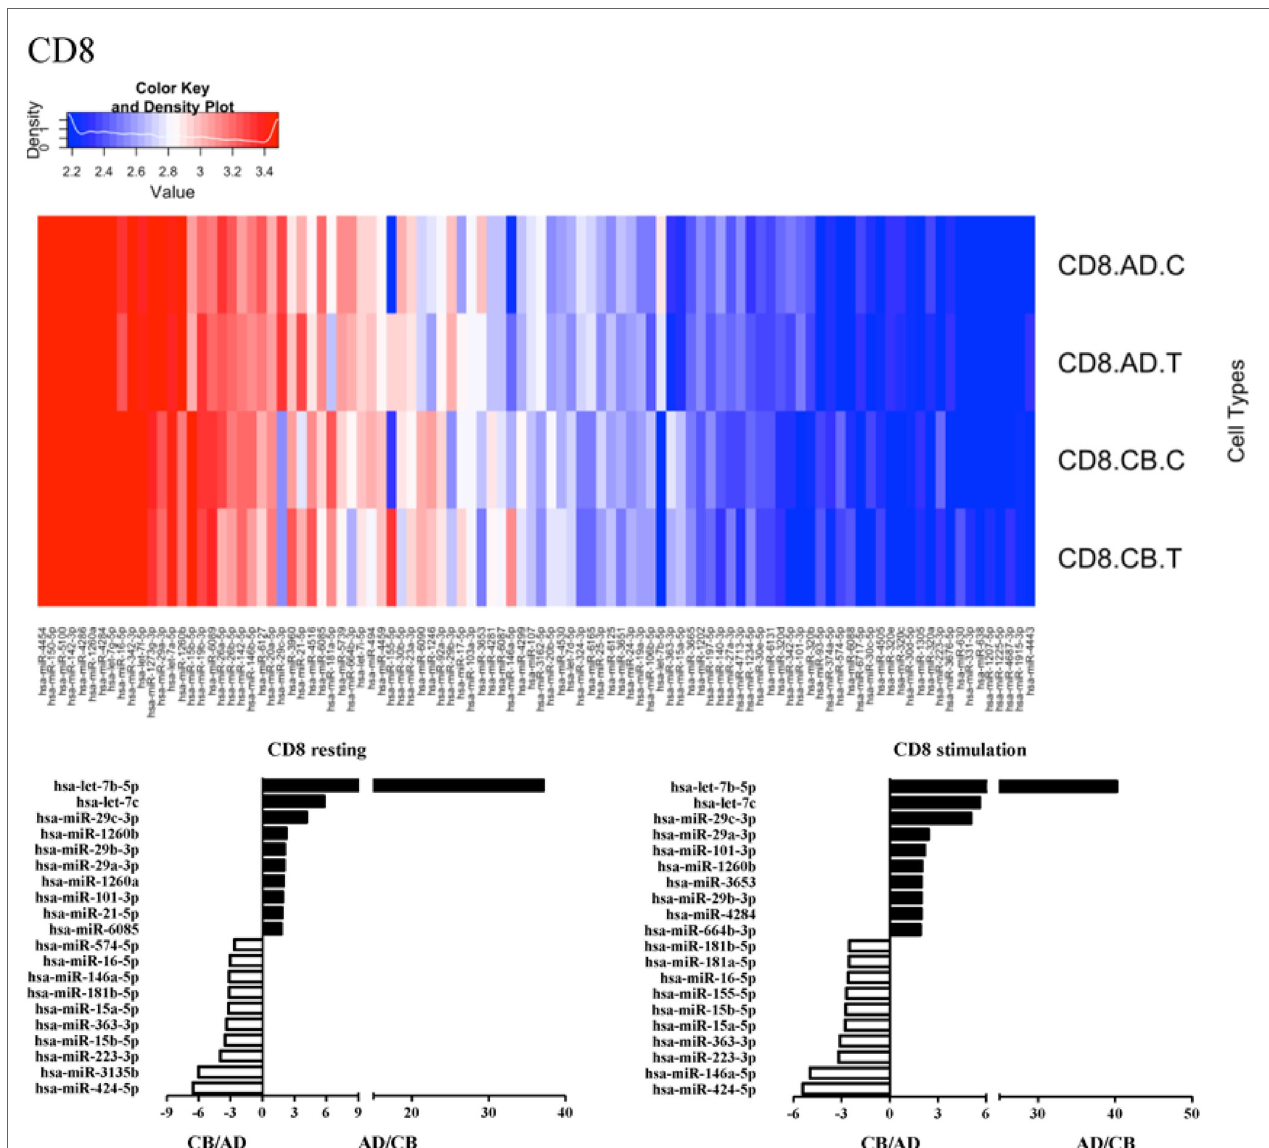
FigUre 5 | Differential microrna profiles between adult and neonatal cD8 + T cells